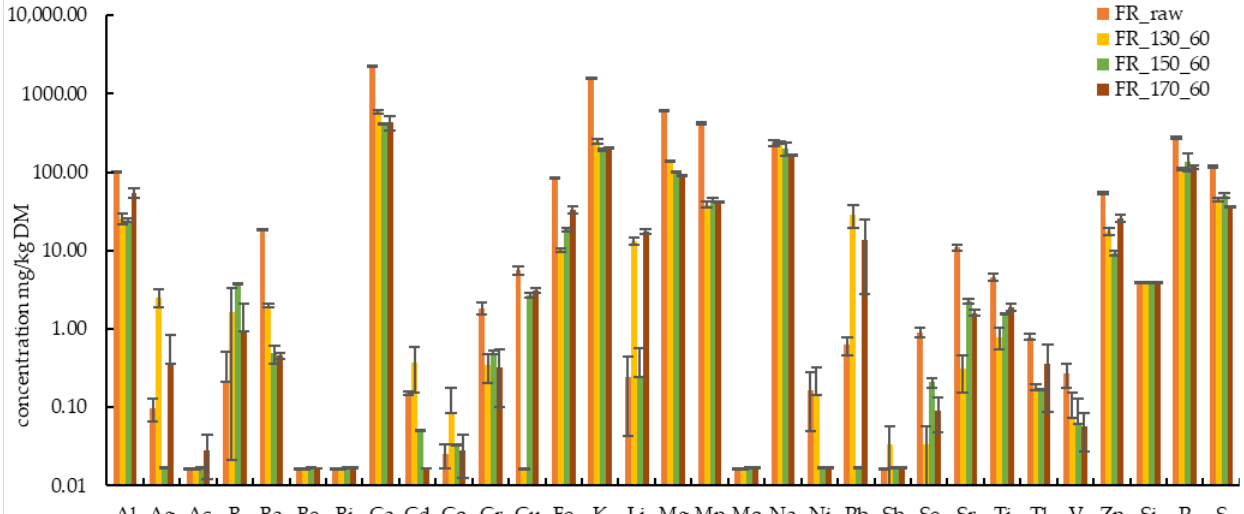
Figure 9. Dry matter (DM) based on mean values ± standard deviations of different elements for the raw and hydrothermally treated forest residue (FR) at 130, 150 and 170 °C with a holding time of 60 min. Numerical values can be found in Appendix A.